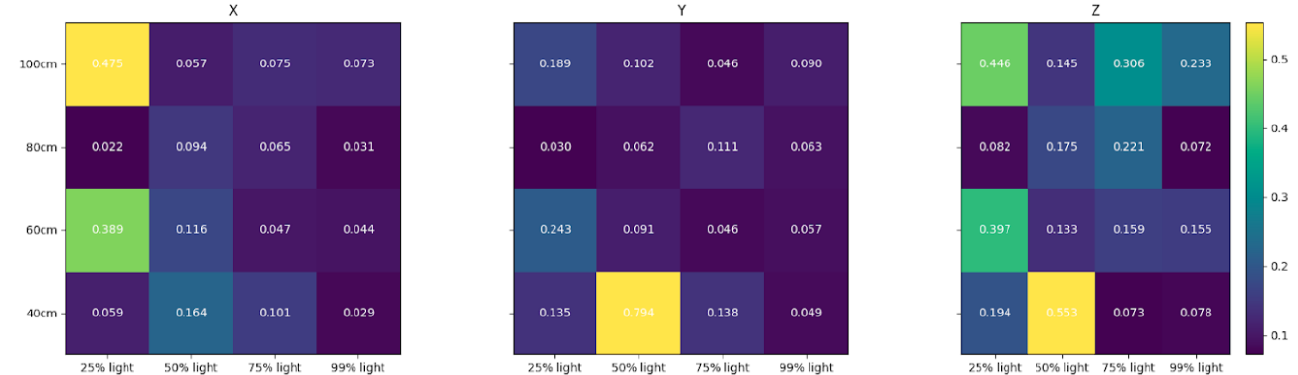
Figure 14. Static noise analysis with varied light intensity levels (25%, 50%, 75%, 100%) and different working distances (0.4, 0.6, 0.8, 1 m). The value is the standard deviation of each component of the position vector. The table cells are color coded to visualize the trends and numeric values are in